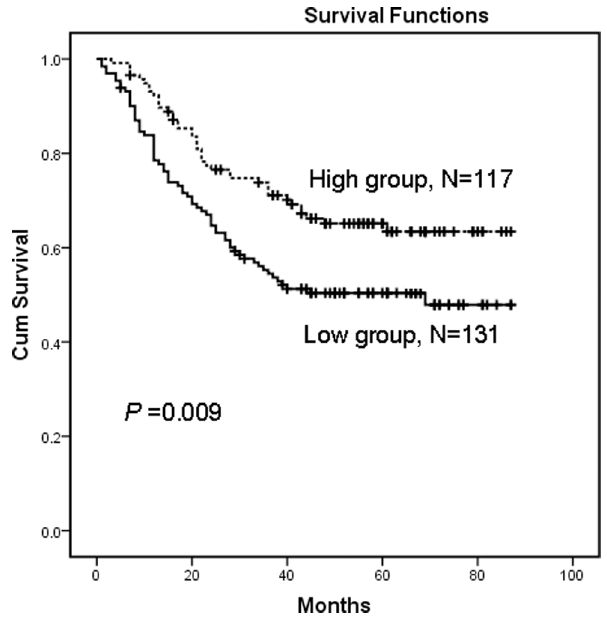
Figure 4. Kaplan–Meier survival curves of gastric cancer patients (n=248) after surgical resection. Low expression of AZGP1 correlated with poor patient survival. Patients in the high AZGP1 expression group exhibited significantly better survival than the low AZGP1 expression group (log-rank test: P= 0.009).